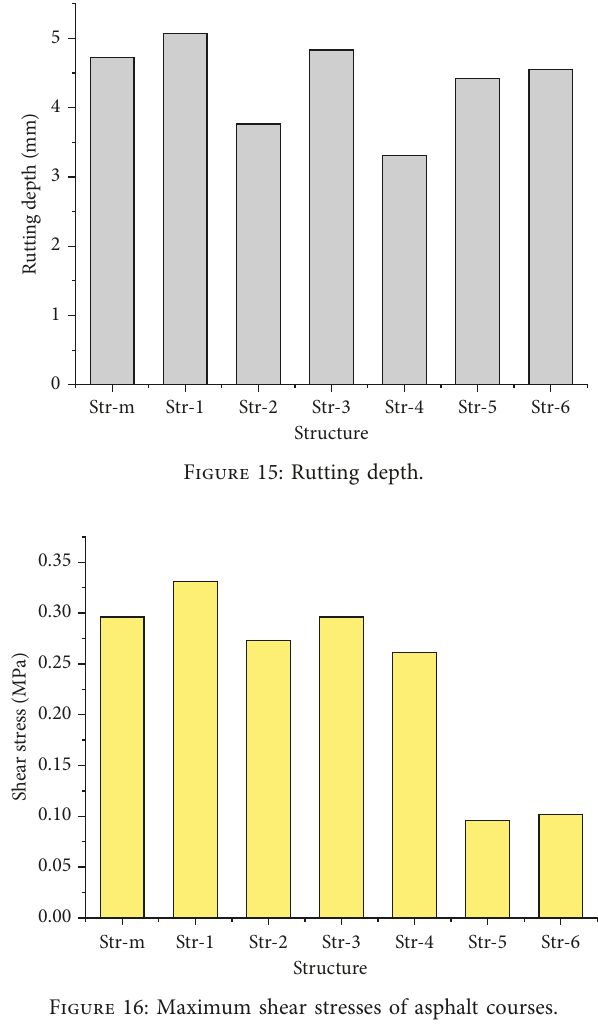
Figure 16: Maximum shear stresses of asphalt